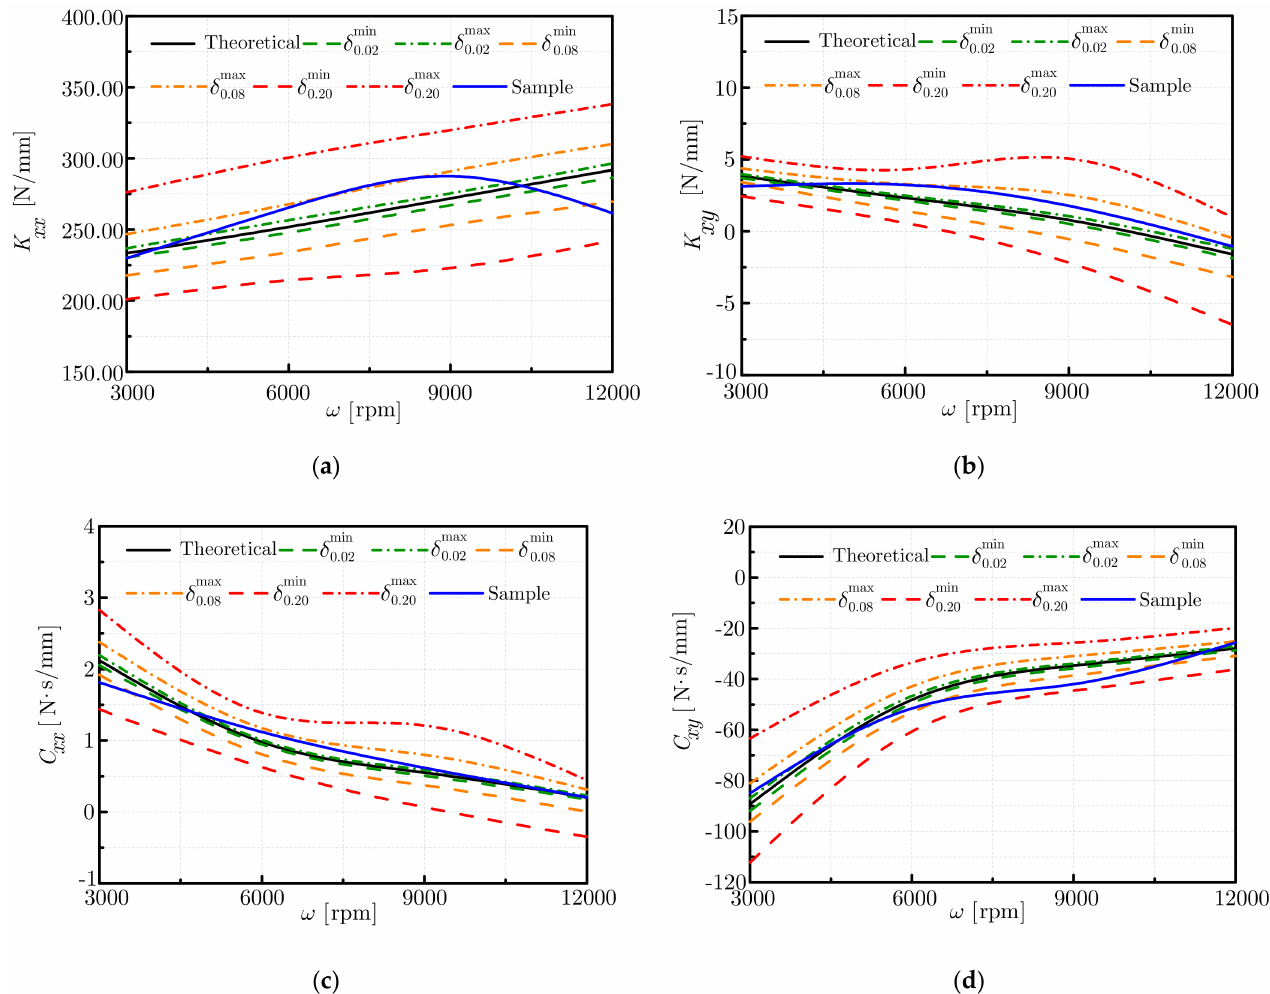
Figure 6. The envelopes of dynamic coefficients against rotor speed for δ R = 0.02, 0.08, and 0.20, where ( a ) is K xx , ( b ) is K xy , ( c ) is C xx , and ( d ) is C xy